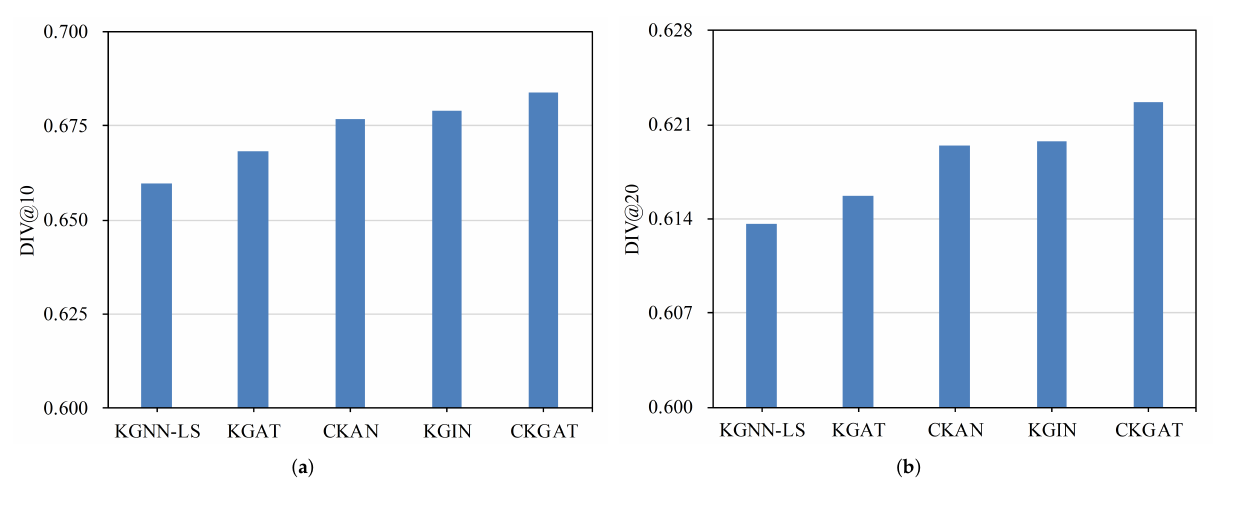
Figure 7. Recommendation diversity performance comparison on the MovieLens 20M